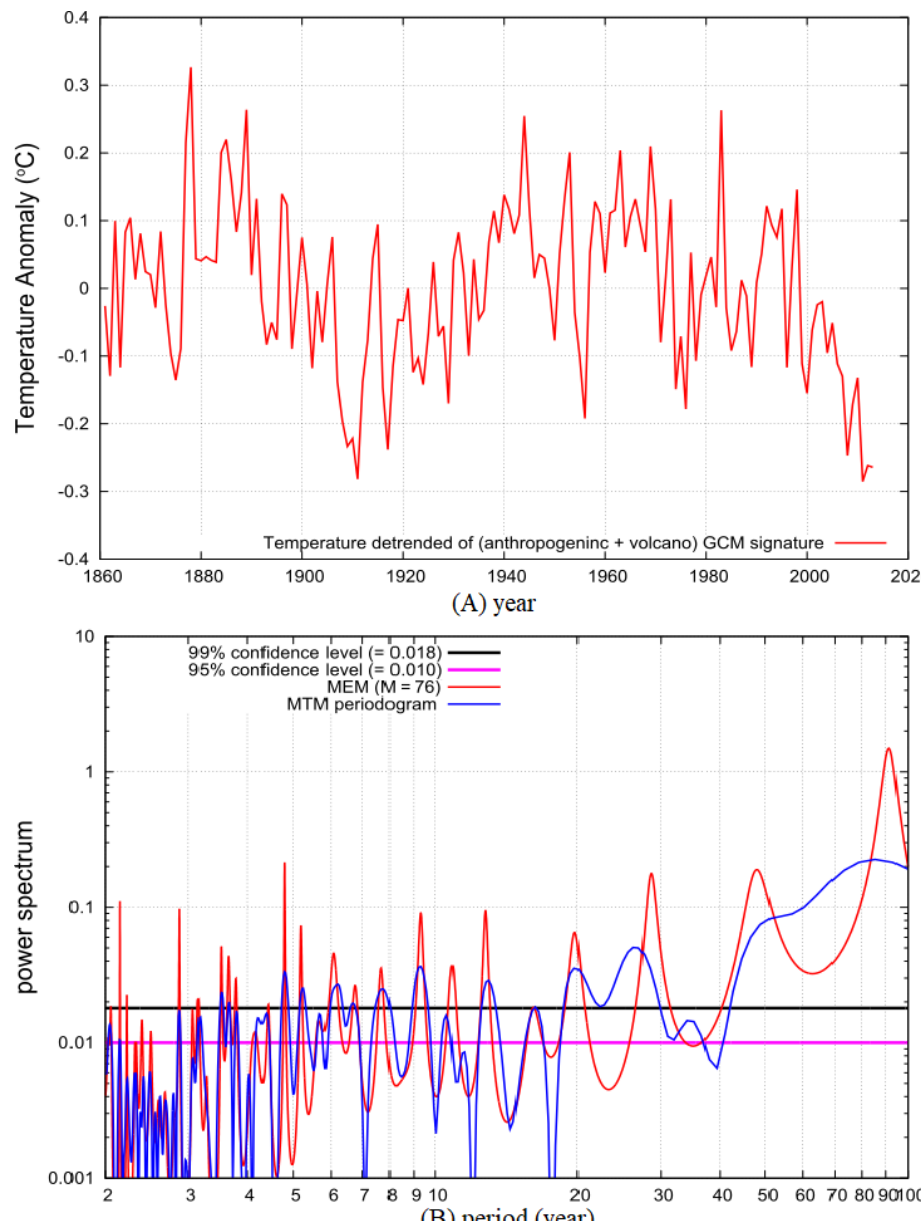
Figure 6. ( A ) HadCRUT4 detrended of the CMIP5 multi-model mean simulation relative to anthro- pogenic and volcanic forcings alone (blue curve in Figure 5), Equation (4). ( B ) Power MTM and MEM spectra of the record depicted in ( A